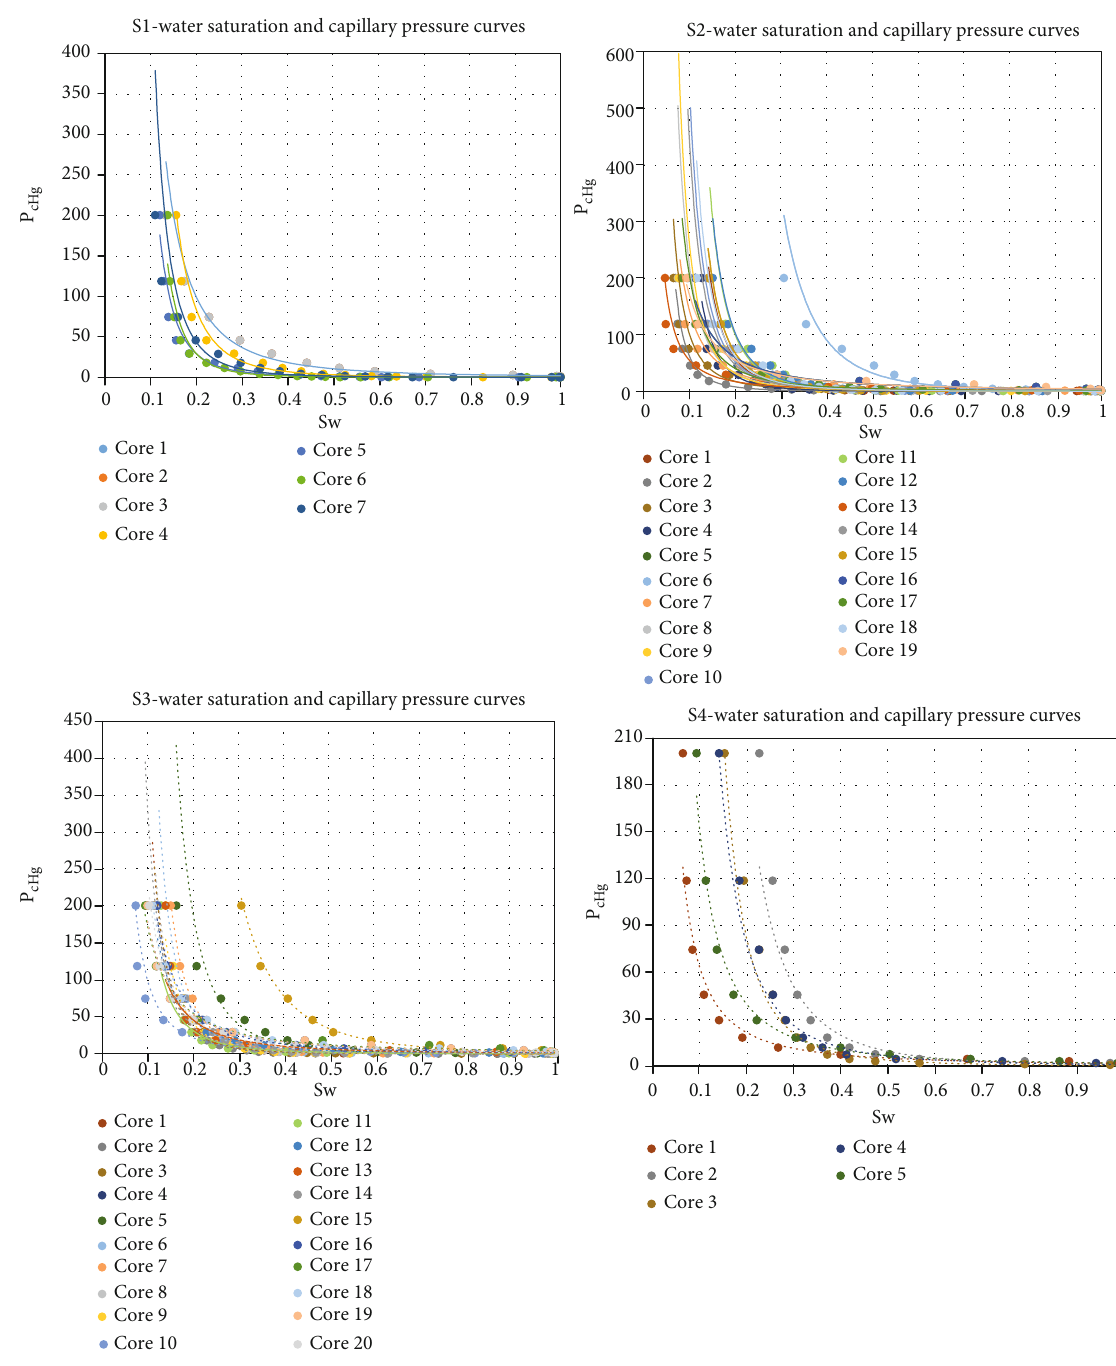
Figure 9: S1 to S4 water saturation and capillary pressure